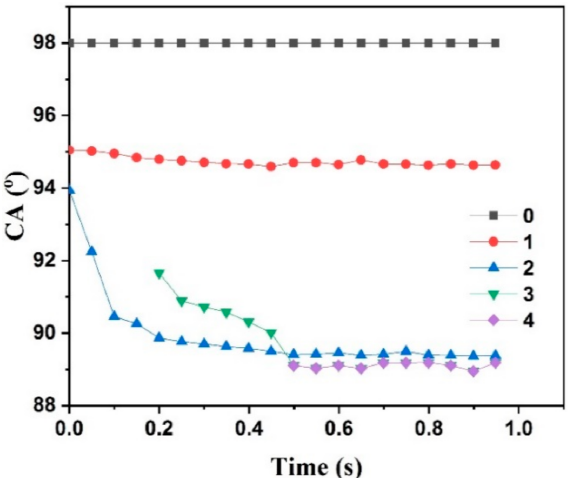
Figure 7. Static contact angles as a function of time for specimens with different H-PAAS mass frac-